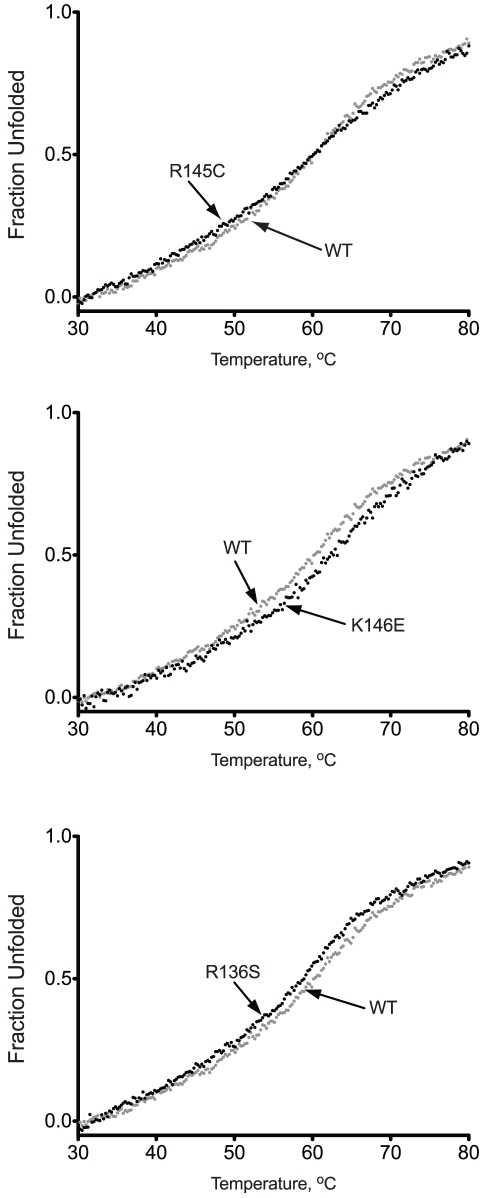
Thermal denaturation profiles of wild-type apoE3 and apoE3 variants.Each apoE3 variant (black dots) is presented in comparison with the wild-type protein (gray dots).